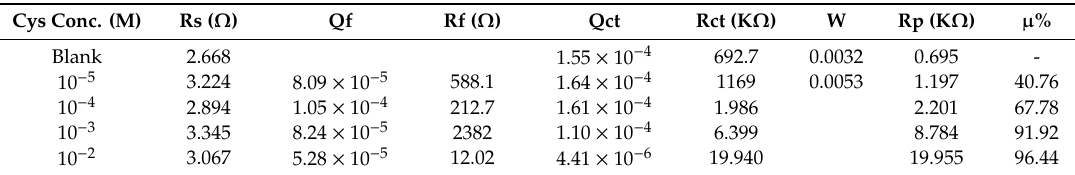
Figure 3. Electrical equivalence circuit for Cu5Zn5Al1Sn alloy in 3.5 wt.% NaCl without R(Q(RW)) ( a ), with 10 − 5 M Cys, R(Q(R(Q(RW)))) ( b ) and 10 − 4 –10 − 2 M Cys, R(Q(R(QR))) ( c ). Legend: solution resistance (Rs), film resistance (Rf), film capacitance (Qf), charge transfer resistance (Rct), double layer capacitance (Qdl), and Warburg resistance (W). Table 2. Impedance parameters for the Cu5Zn5Al1Sn alloy in 3.5 wt.% NaCl with and without di ff erent concentrations of cysteine obtained by using ZSimpWin